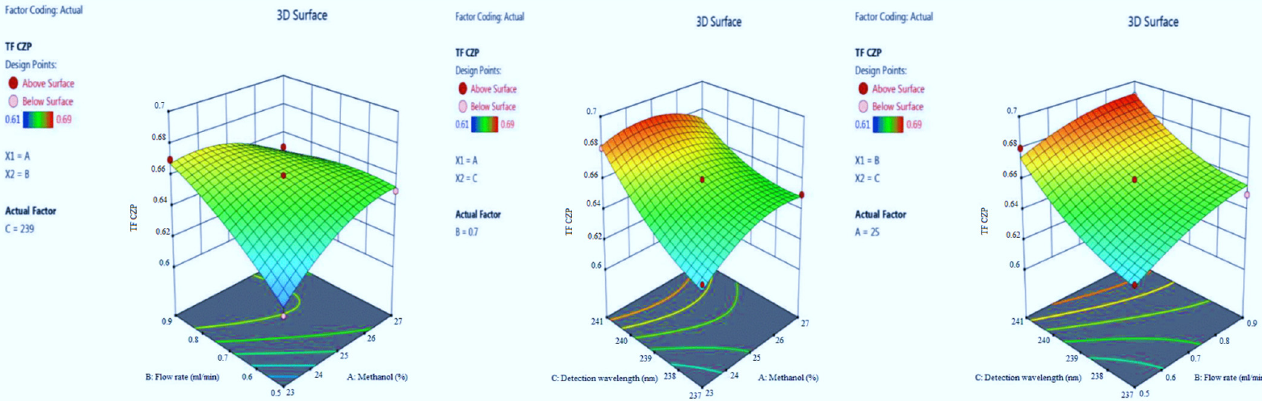
Figure 9. 3D responses for CZP tailing factor in terms of AB, AC, and BC.